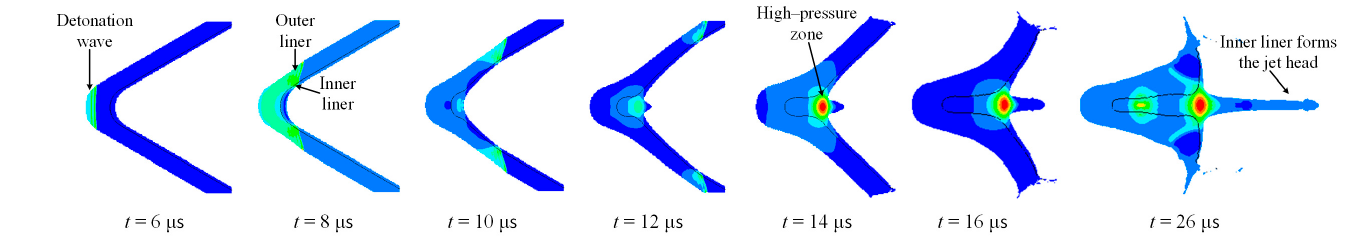
Figure 11. Typical detonation wave propagation and composite jet formation process.